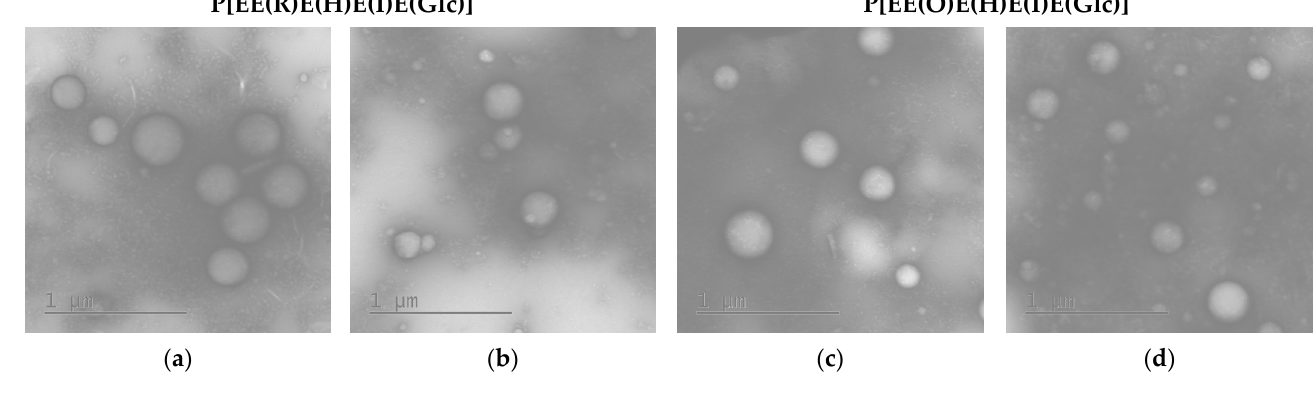
Figure 5. TEM images of empty ( a,c ) and PTX ‐ loaded ( b,d ) nanoparticles based on P[EE( R )E(H)E( I )E(Glc)] ( a,b ) and P[EE( O )E(H)E( I )E(Glc)] ( c,d ). As in the case of DLS results, the average diameter of the PTX ‐ loaded nanoparticles was also lower. According to TEM, the 𝐷(cid:3365) values for PTX nanoformulations were 210 ± 56 (PDI = 0.22) for the P[EE(R)E(H)E(I)E(Glc)] delivery system and 185 ± 59 (PDI = 0.31) for the P[EE(O)E(H)E(I)E(Glc)] delivery system. In this case, the particle size values were 20–